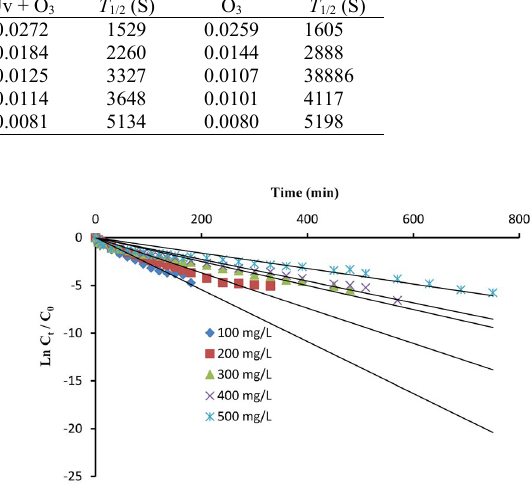
= 500 Fig. 8. Kinetics of the Direct Yellow 12 UV assisted ozonation (O 3 = 500 mg/h, treated volume = 200 ml, initial solution